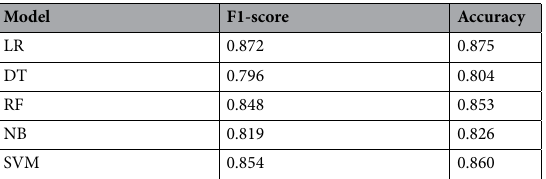
Table 5. Classification with leave-one-out cross validation on the first wave dataset, with the top six clinical variables selected by our GA algorithm, after imputation of missing values (265 patients). Each row corresponds to a different model type.